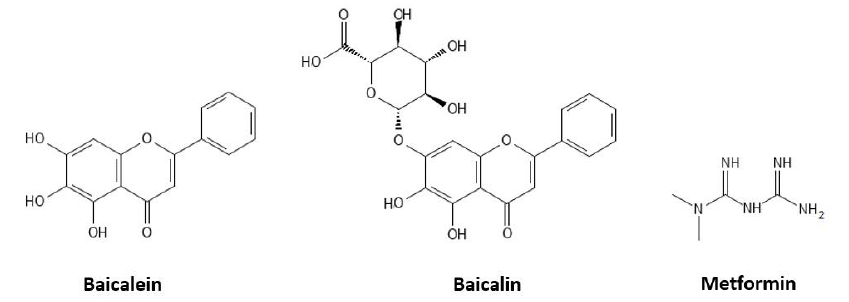
Figure 1. Chemical structures of baicalein, baicalin, and metformin.